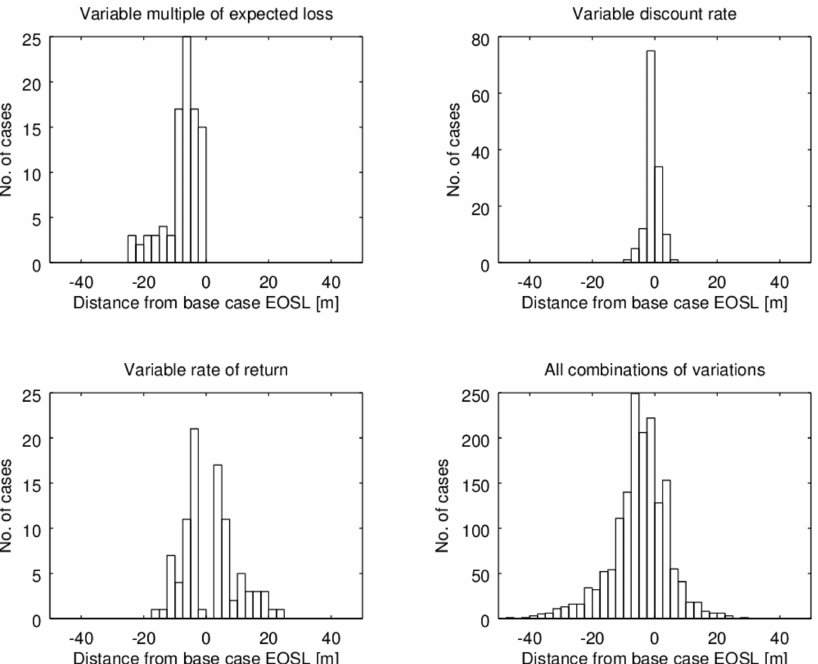
Figure 24. The distance between the EOSL based on the base case parameter values and the EOSL based on different economic constants. Results for profiles in Batticaloa, assuming they all lie in high-value zones. A negative distance implies a position seaward of the base case EOSL.